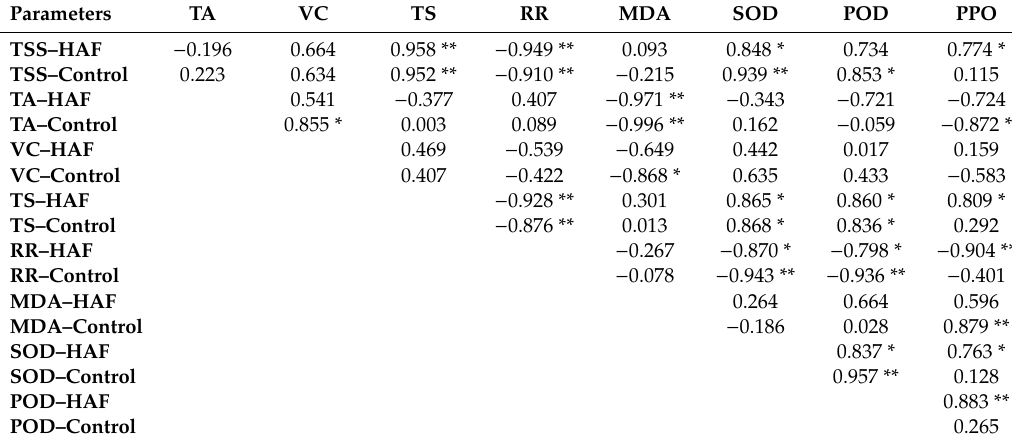
Table 1. Pearson correlation among the observed quality parameters of the HAF-treated and control